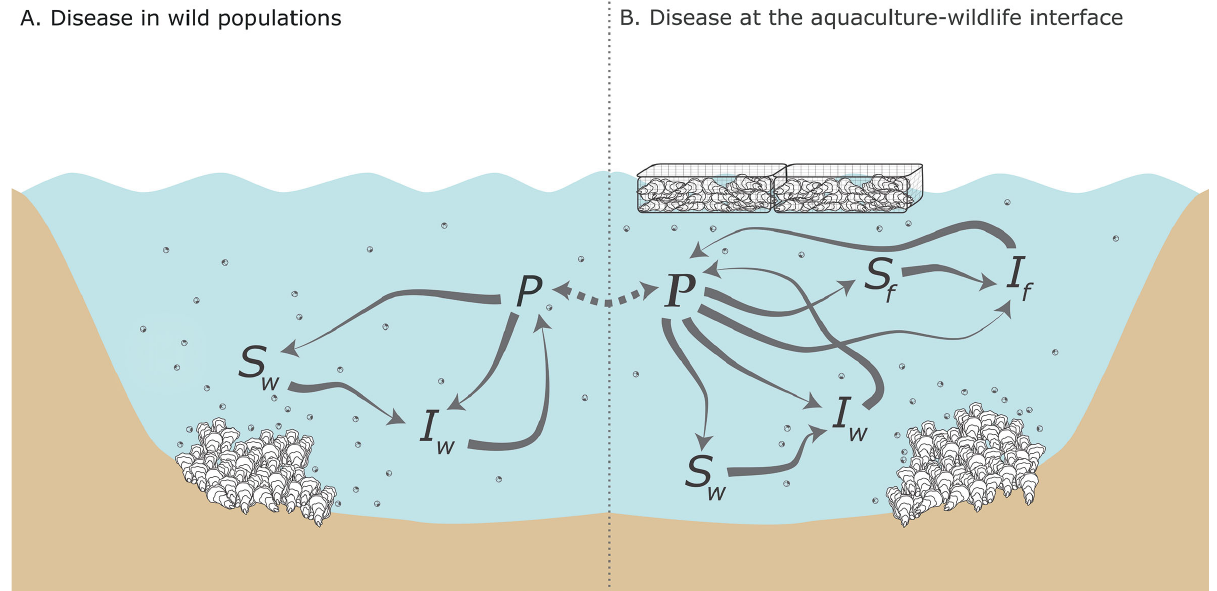
Fig. 1. The interactions between susceptible and infected host classes and water-borne parasite stages in (A) a wild oyster pop- ulation in the absence of aquaculture and (B) when wild and culture populations are sympatric. The dashed line demonstrates the export and import of parasite stages between the local populations. See Table 1 for definition of